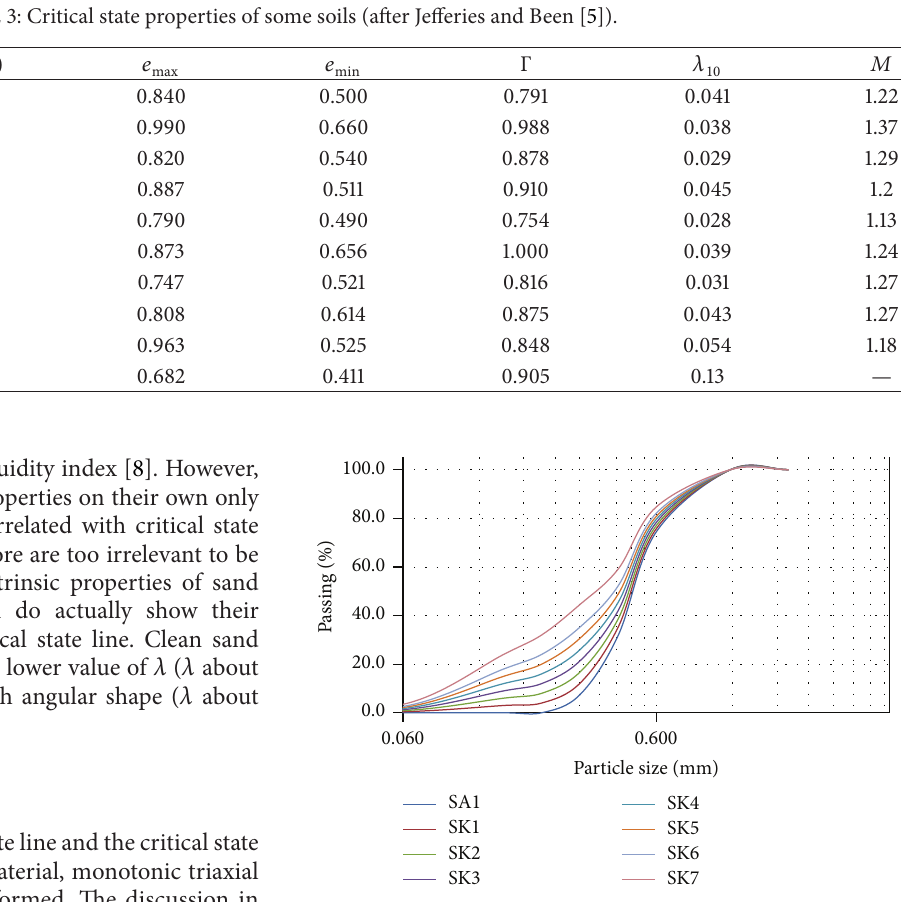
Figure 2: Particle size distribution of the tested soils.